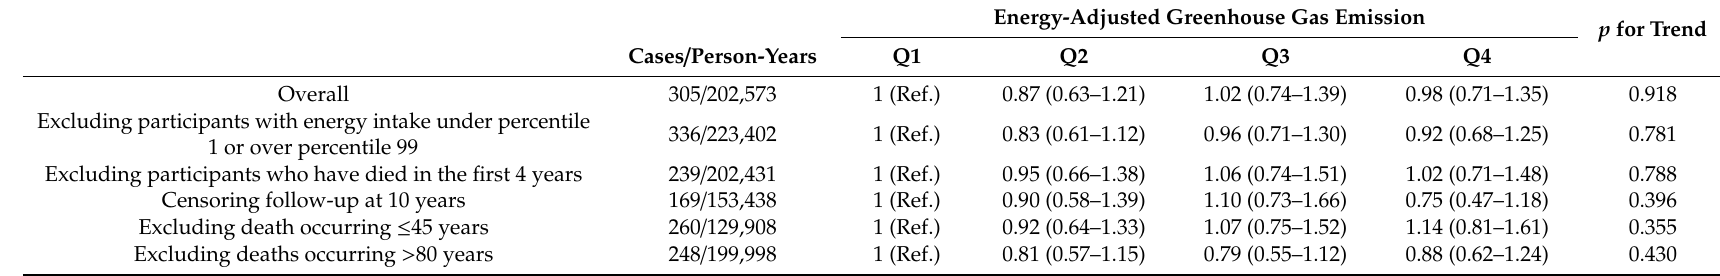
Table 4. Sensitivity analyses. Risk for all-cause mortality (hazard ratio and 95% confidence intervals) of the 17,387 participants of the SUN assessed in the current study, 1999–2019, according to quartiles of the energy-adjusted dietary greenhouse gas